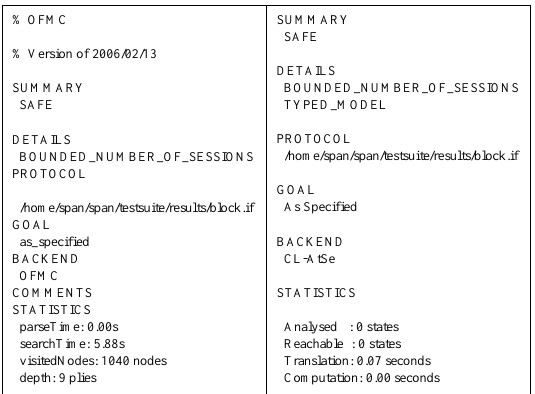
Figure 12. HLPSL syntax of session and environment.